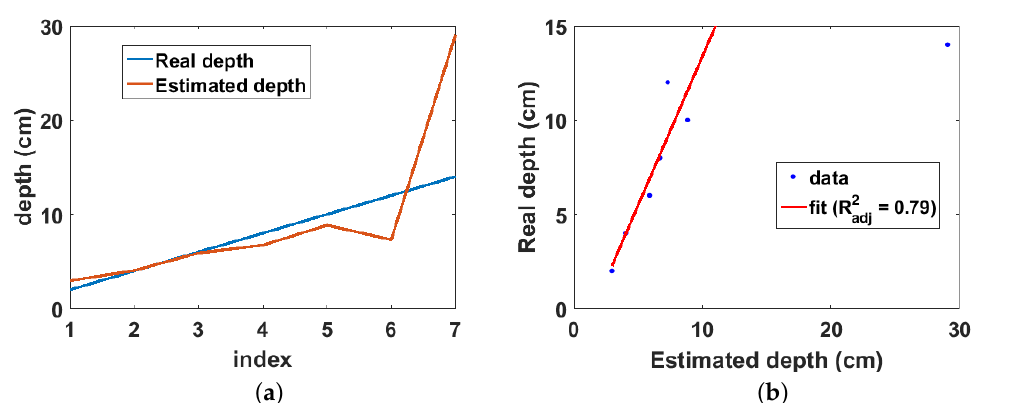
Figure 13. ( a ) real and estimated depths from experiment. Index is the position of each depth value in the depth array; ( b ) linear fit of real and estimated depths from